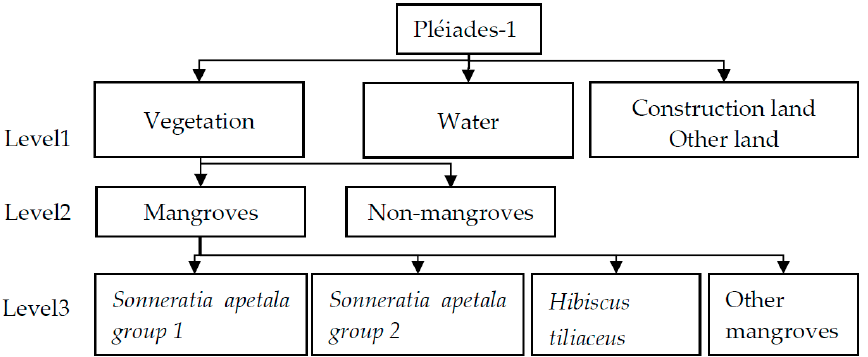
Figure 3. The three-level hierarchy model of mangroves classification.